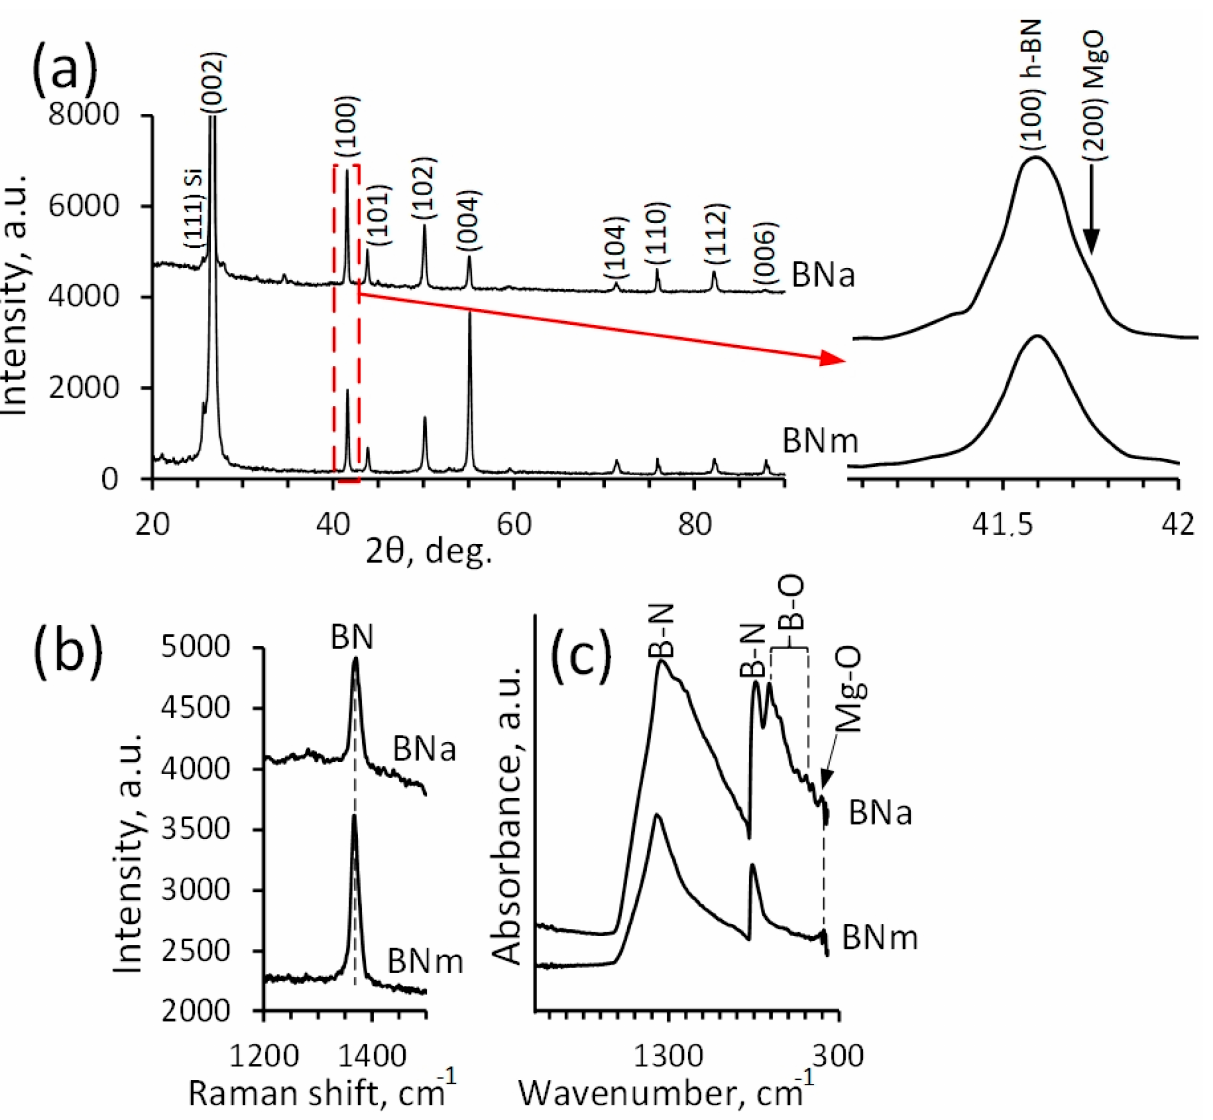
Figure 4. XRD patterns ( a ), Raman spectra ( b ), and FTIR spectra ( c ) of BN m and BN a samples. According to the EDXS analysis, the Ag content in both samples is the same (~1.5 at.%). The results of the structural analysis show that the BN surfaces are covered with Ag NPs having two characteristic sizes. Relatively large Ag NPs are 8–35 nm in size (Figure 5a,b). At higher magnification, very small Ag NPs (1–2 nm in dimension) are observed on the BN surface. In sample BN a , Ag NPs precipitated predominantly along the defect boundaries (Figure 5c). The high-resolution TEM image shows the coexistence of Ag and MgO NPs (Figure 5d). The observed characteristic interplanar spacings of 0.206 and 0.213 nm can be attributed to the (200) MgO (JCPDS card No. 89-7746) and (111) Ag (JCPDS card No. 04-0783) planes,